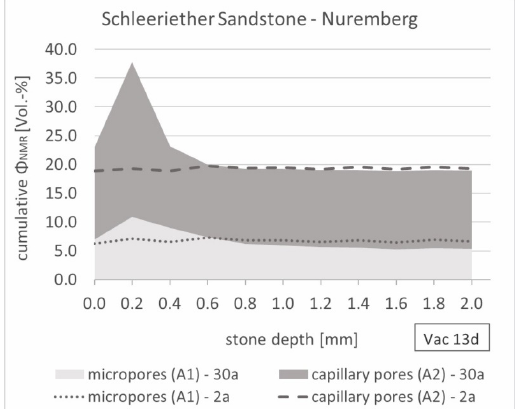
Figure 9. Fitted and stacked relaxation depth profile of the 2- and 30-year weathered Schleeriether Sandstone samples (exposure site: Nuremberg) saturated under vacuum (0.05 bar).